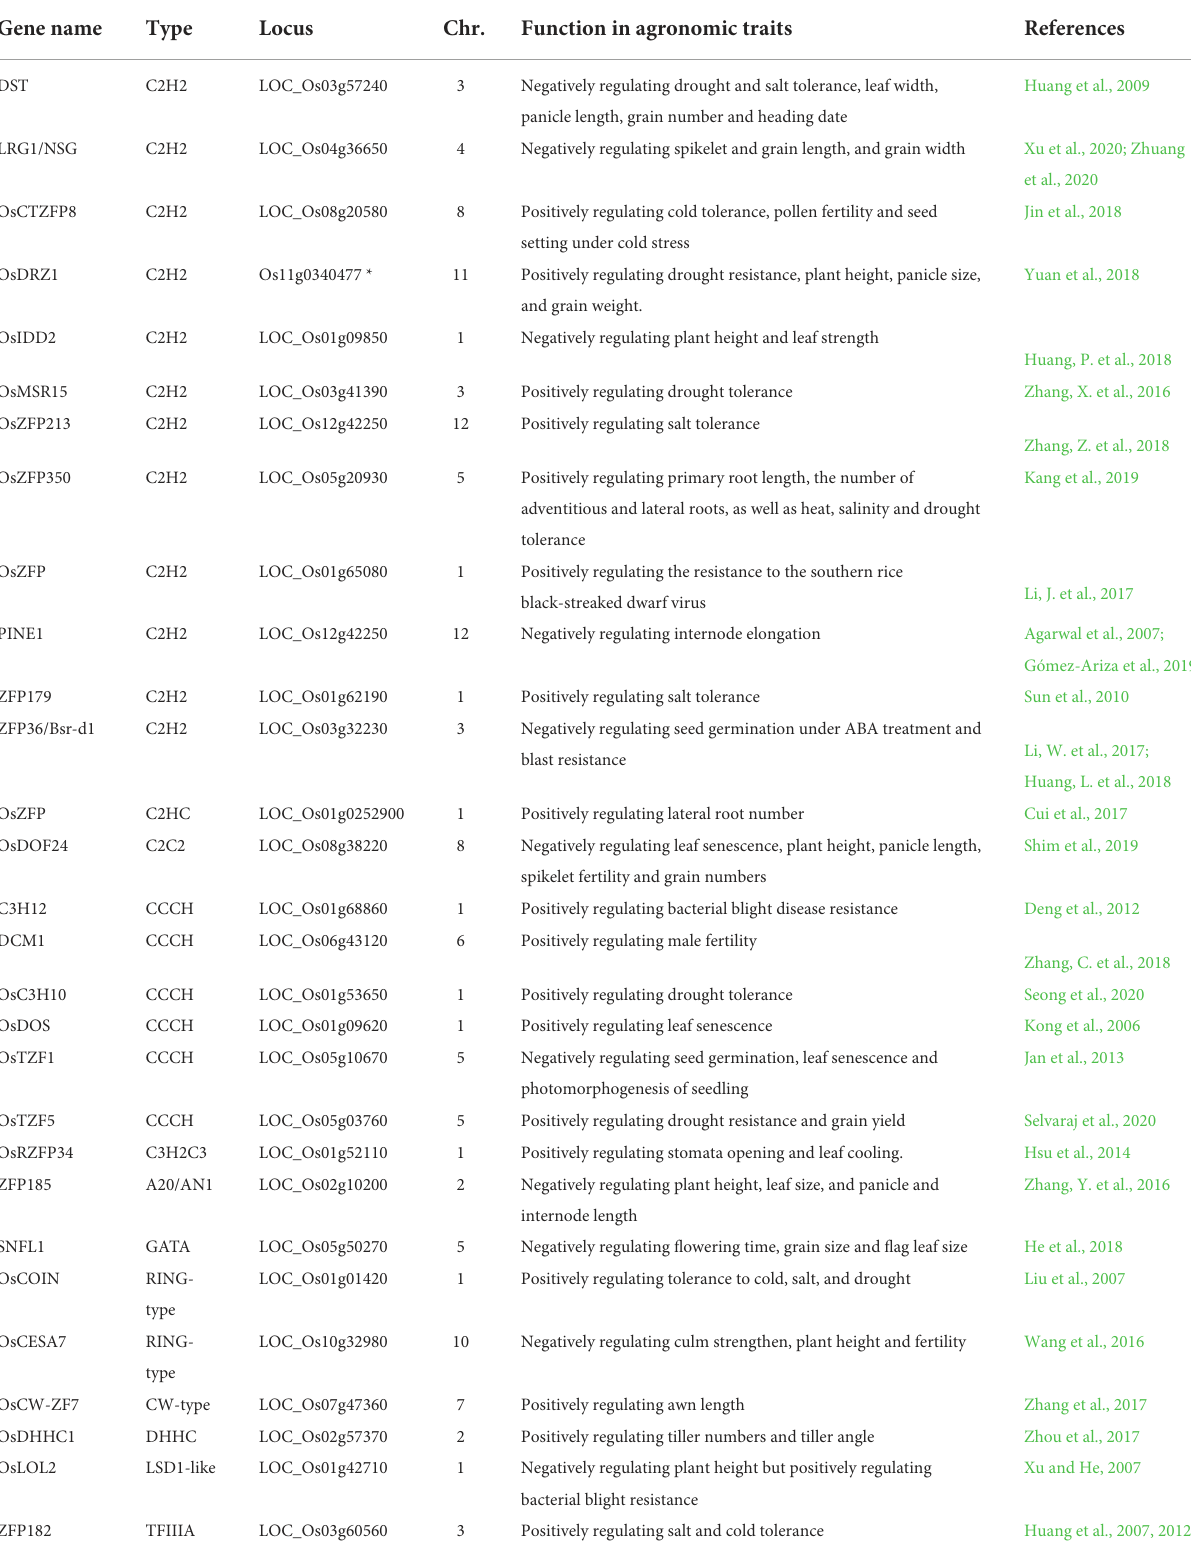
TABLE 1 Representatives of the zinc finger protein in